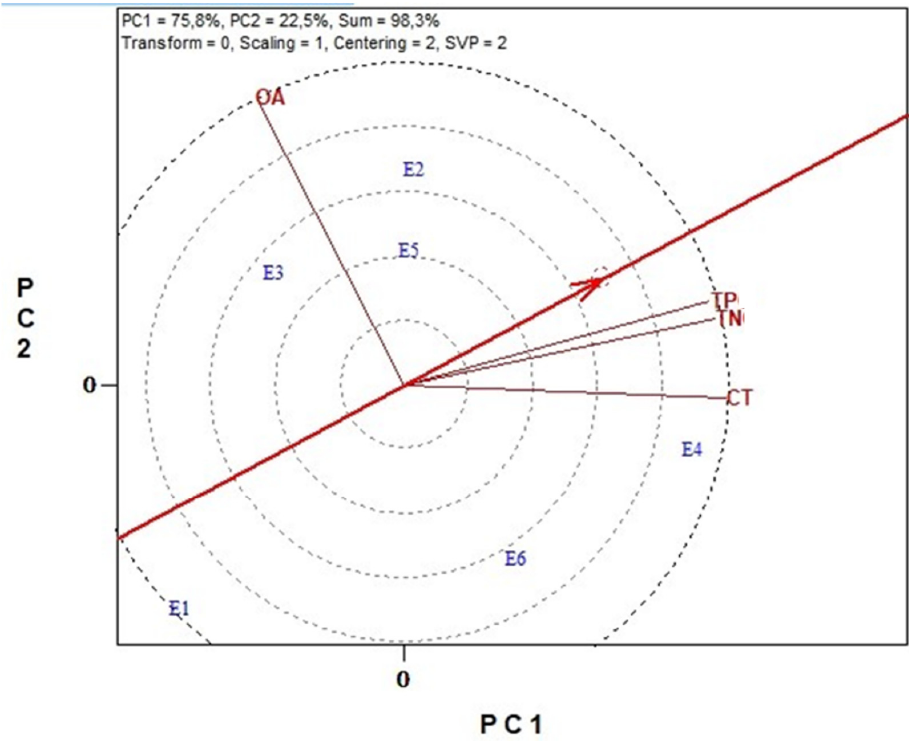
Figure 9. “Discriminativeness vs. representativeness” view of the GGE biplot for six testing environments of four antinutritional traits, averaged across seven genotypes of V. sativa .